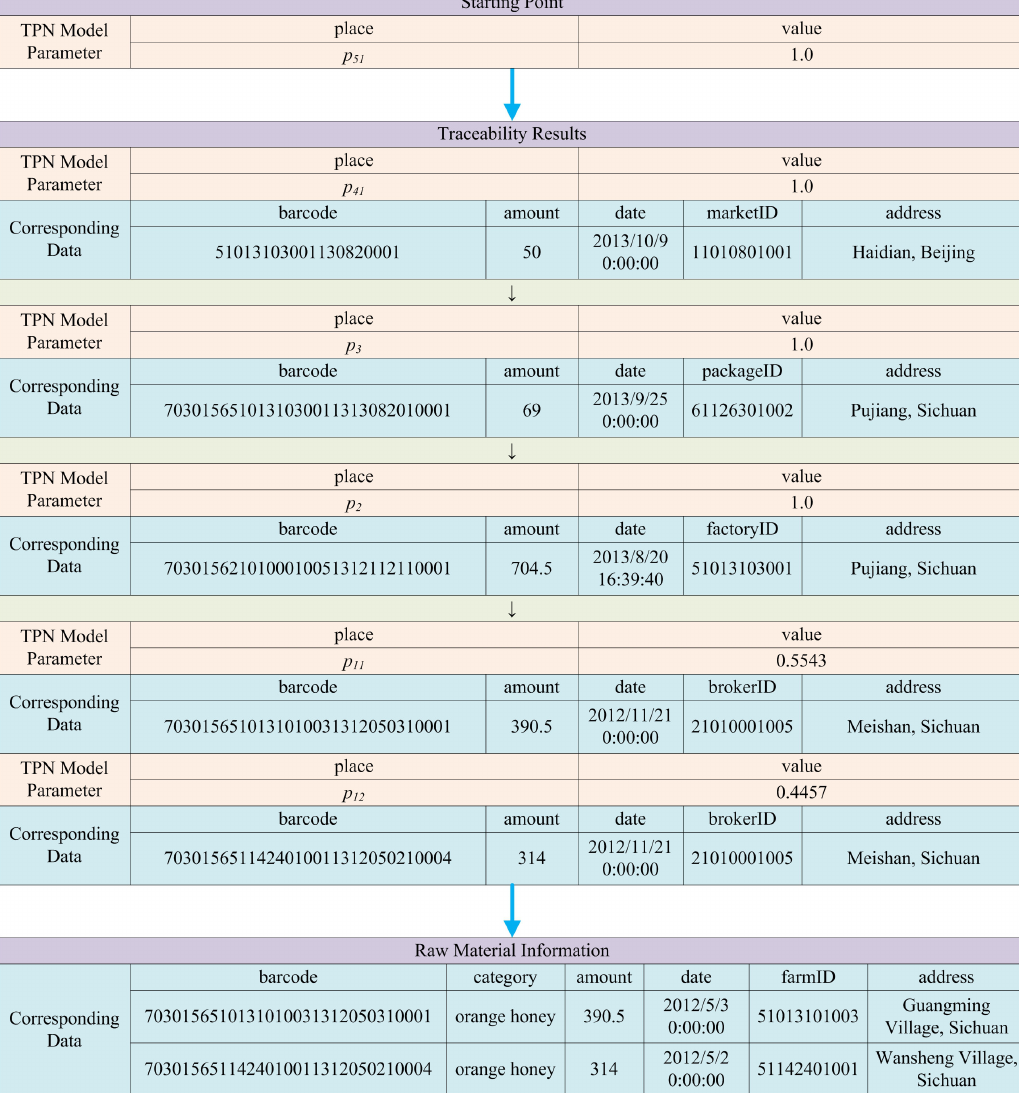
Figure 14. Results of traceability analysis of an orange honey